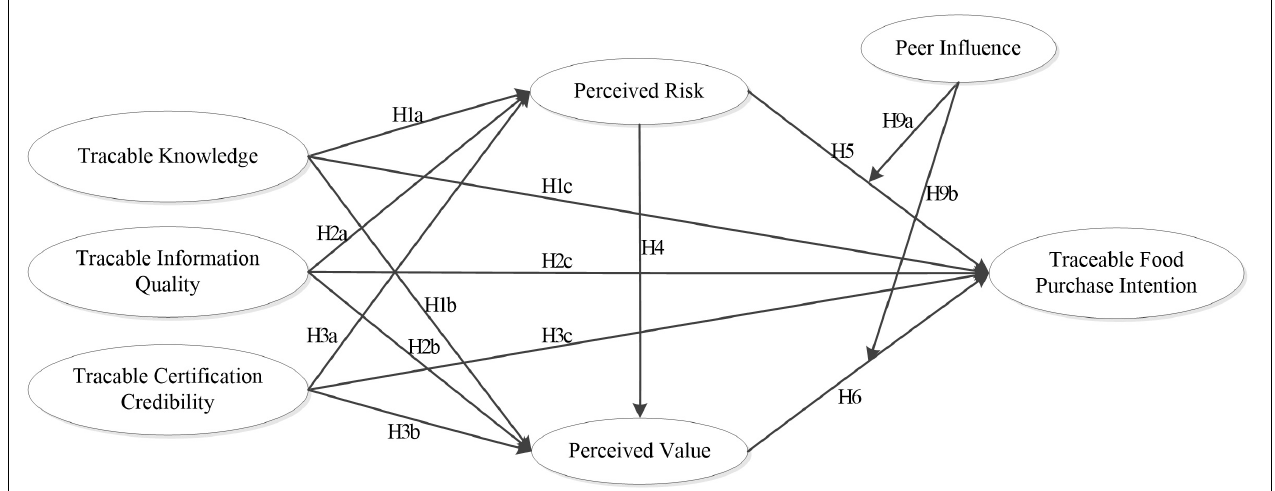
FIGURE 1 | Research